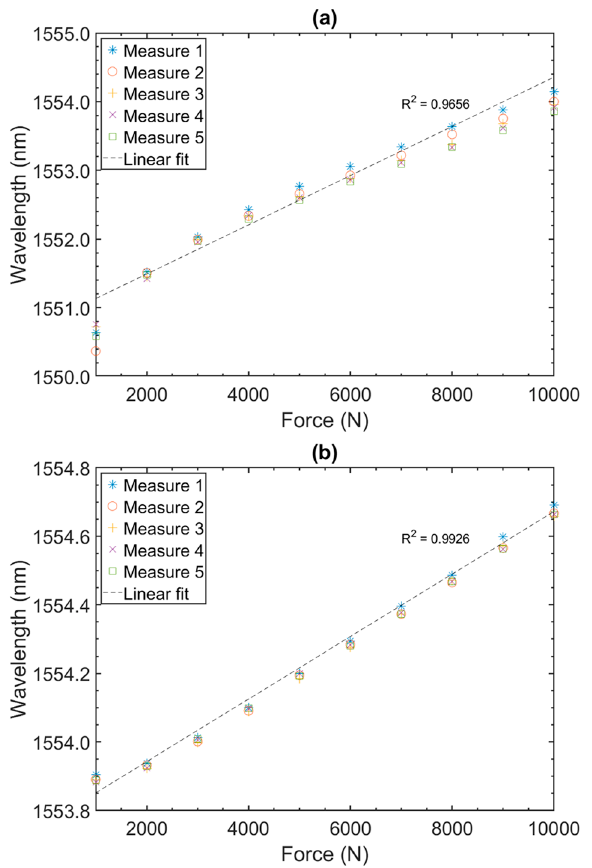
Figure 8. Static test results performed on PEEK ( a ) and TB ( b ) sensors for force values from 1000 to 10,000 N.